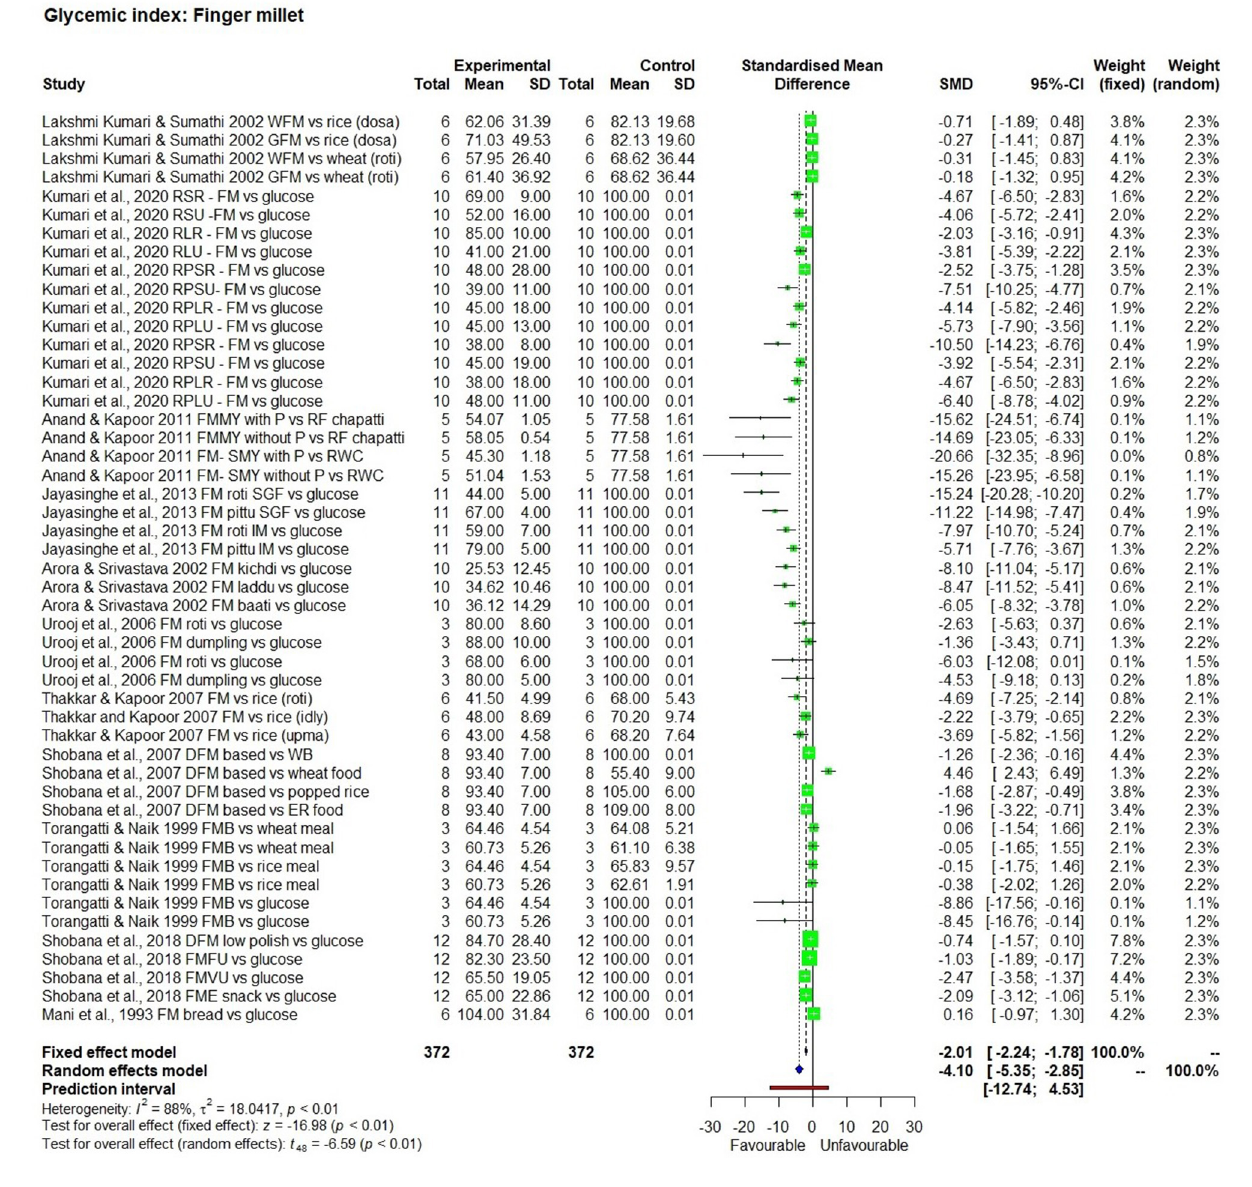
heterogeneity (93%) and significantly low GI ( p < 0.01) with 95% confidence interval of − 10.15; −